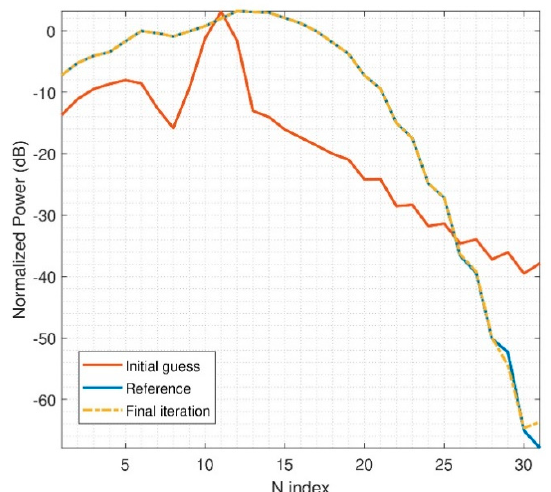
Figure 9. N ‐ power spectrum of reconstructed field, r 0 = 8 λ , d = 5 λ , 3 arch rotations. Figure 9. N-power spectrum of reconstructed field, r